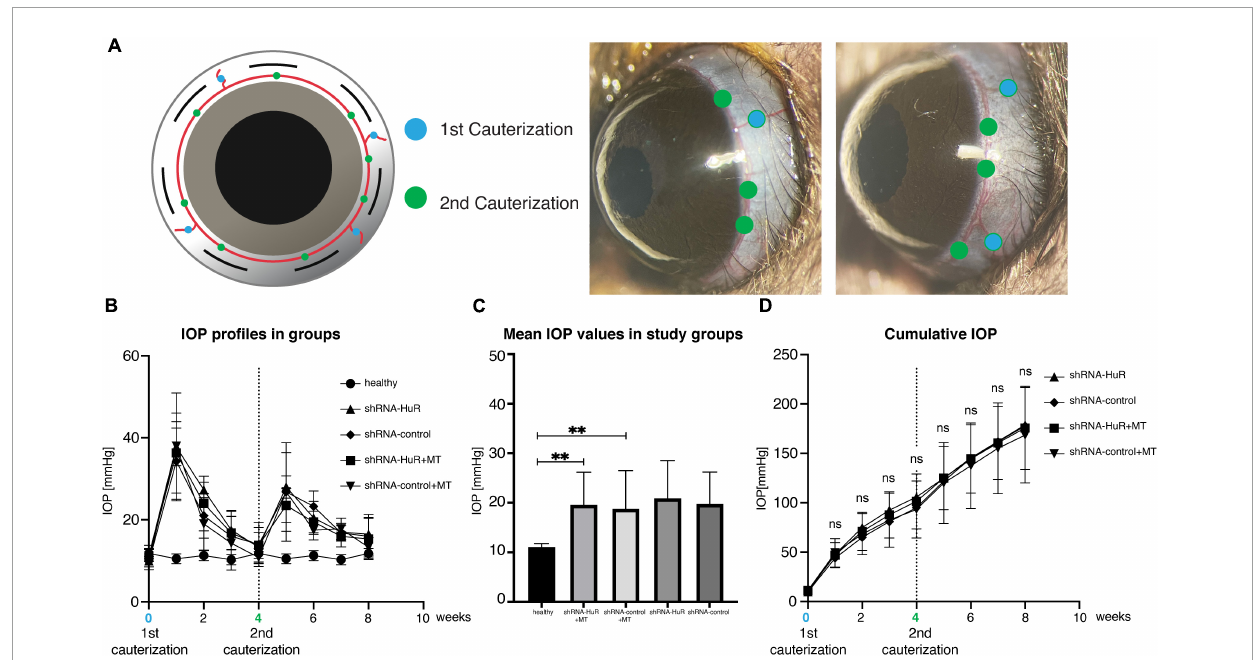
FIGURE5 Glaucoma model. (A) The methodology of exogenous neuroprotection study—the thermocoagulation of episcleral and limbal vessels in rat eye (blue marker identifies episcleral veins, green marker—limbal vessels). Four episcleral veins were cauterized using thermal cautery (1st cauterization). Additional cauterization was performed on limbal vessels between episcleral veins after 4 weeks to produce a longer-lasting IOP elevation (2nd cauterization). (B) IOP profiles of the groups after 1st and 2nd cauterization. (C) The mean IOP induced in experimental groups (shRNA-HuR and shRNA-control) were significantly higher when compared with healthy eyes. (D) Cumulative IOP induced in glaucoma model. ∗∗ p < 0.01, ns, not